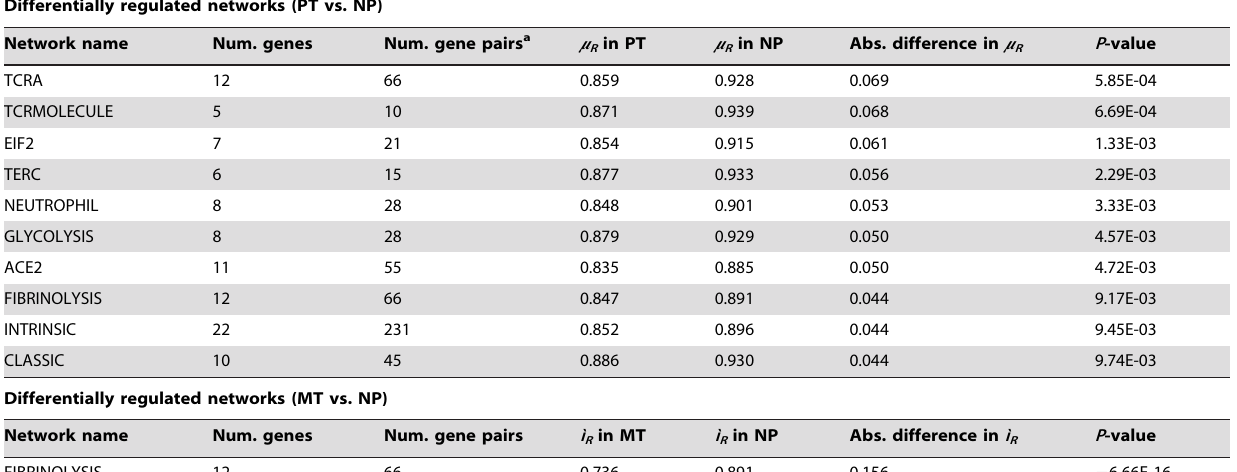
Differentially regulated networks (PT vs.